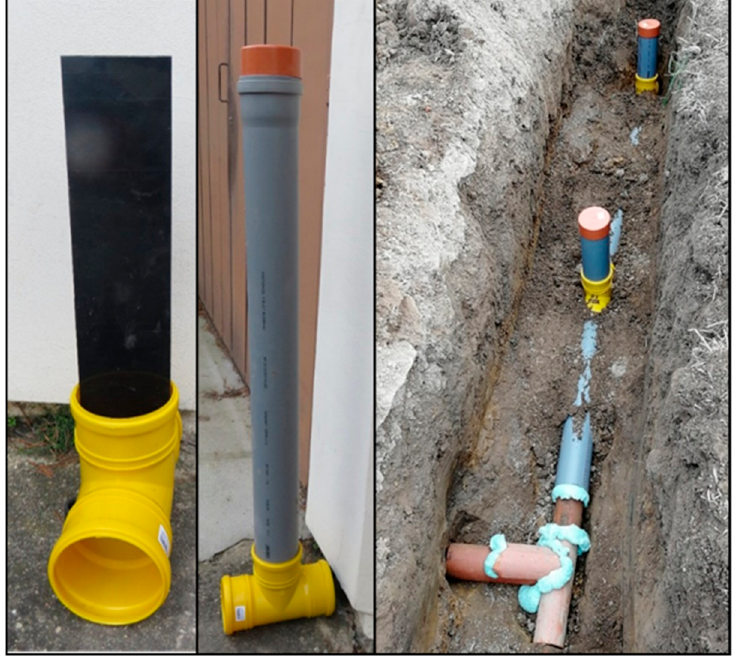
Figure 2. Underground fixed WLCS consisting of a drainage T branch (yellow), a polypropylene gate (black) and a PVC pipe vertically connected to the T branch (grey) with a cap (brick-red); before and after installation on tile drainage.